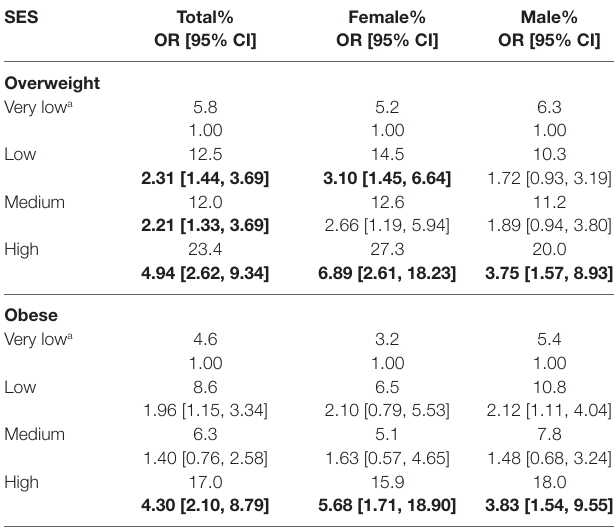
TaBle 2 | Comparison of overweight and obesity prevalence by region within gender-specific and aggregated groups. region